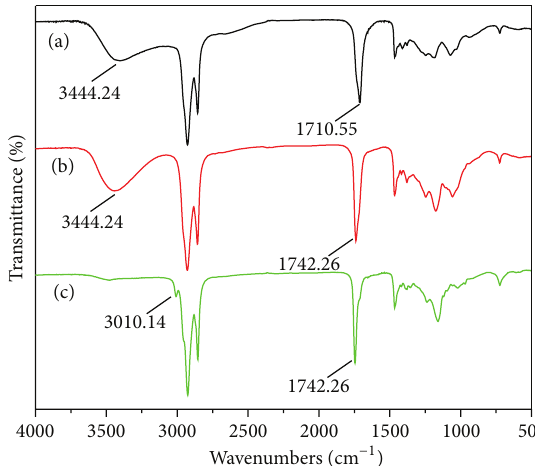
Figure 4: FTIR spectra of HFA (a), SPE (b), and UPE (c).